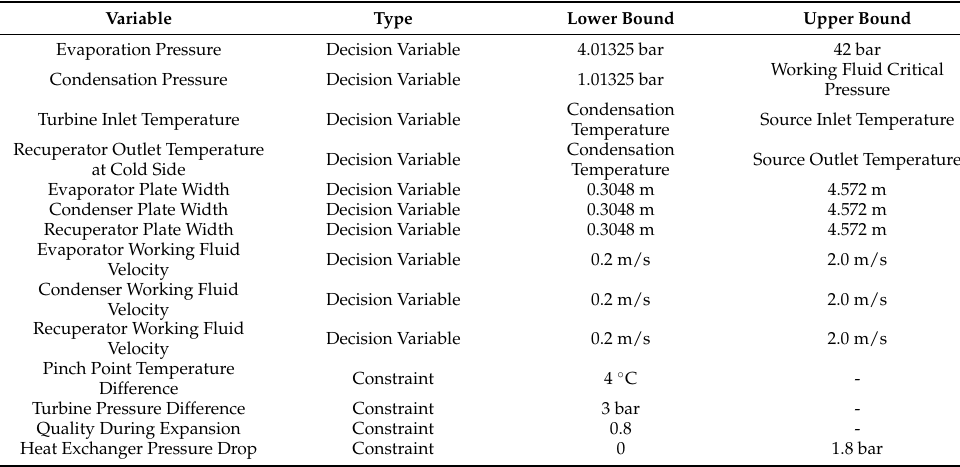
Table 2. Lower and upper bounds of the optimized ORC decision variables.